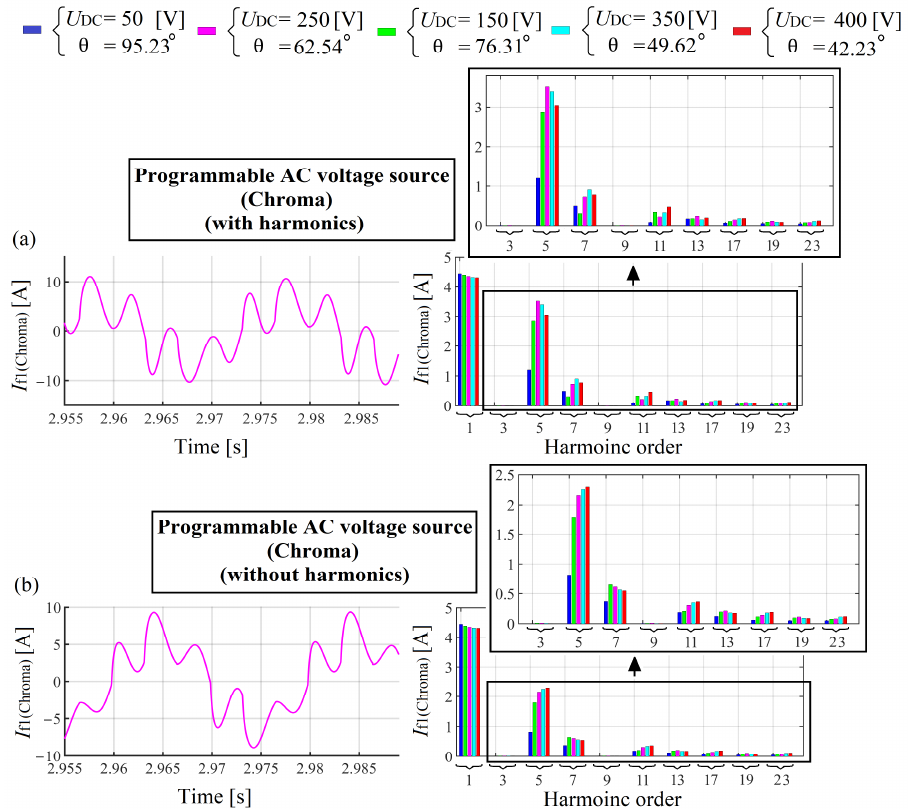
Figure 34. Current waveforms and spectrums measured at the filter terminals when the program- mable voltage source was with: ( a ) harmonics and ( b ) without harmonics. The line reactor L SS is considered.